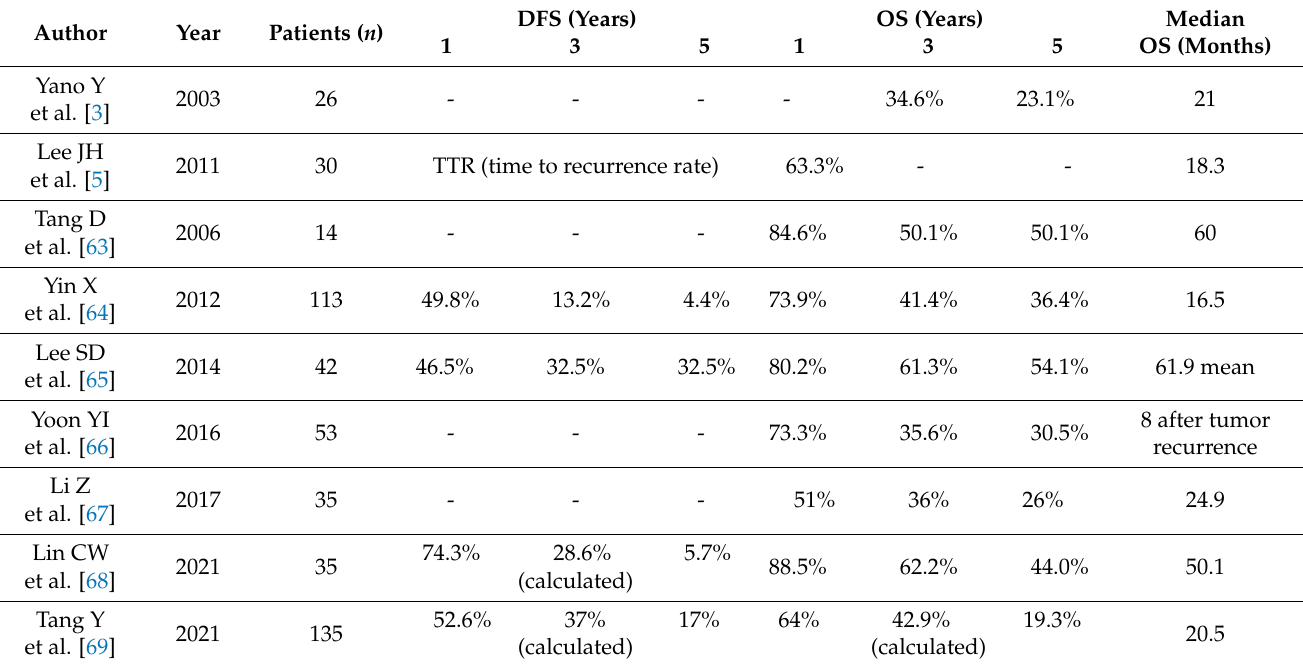
Table 1. Comparative, retrospective analysis of long-term oncological outcomes after liver resection for cHCC-CC.